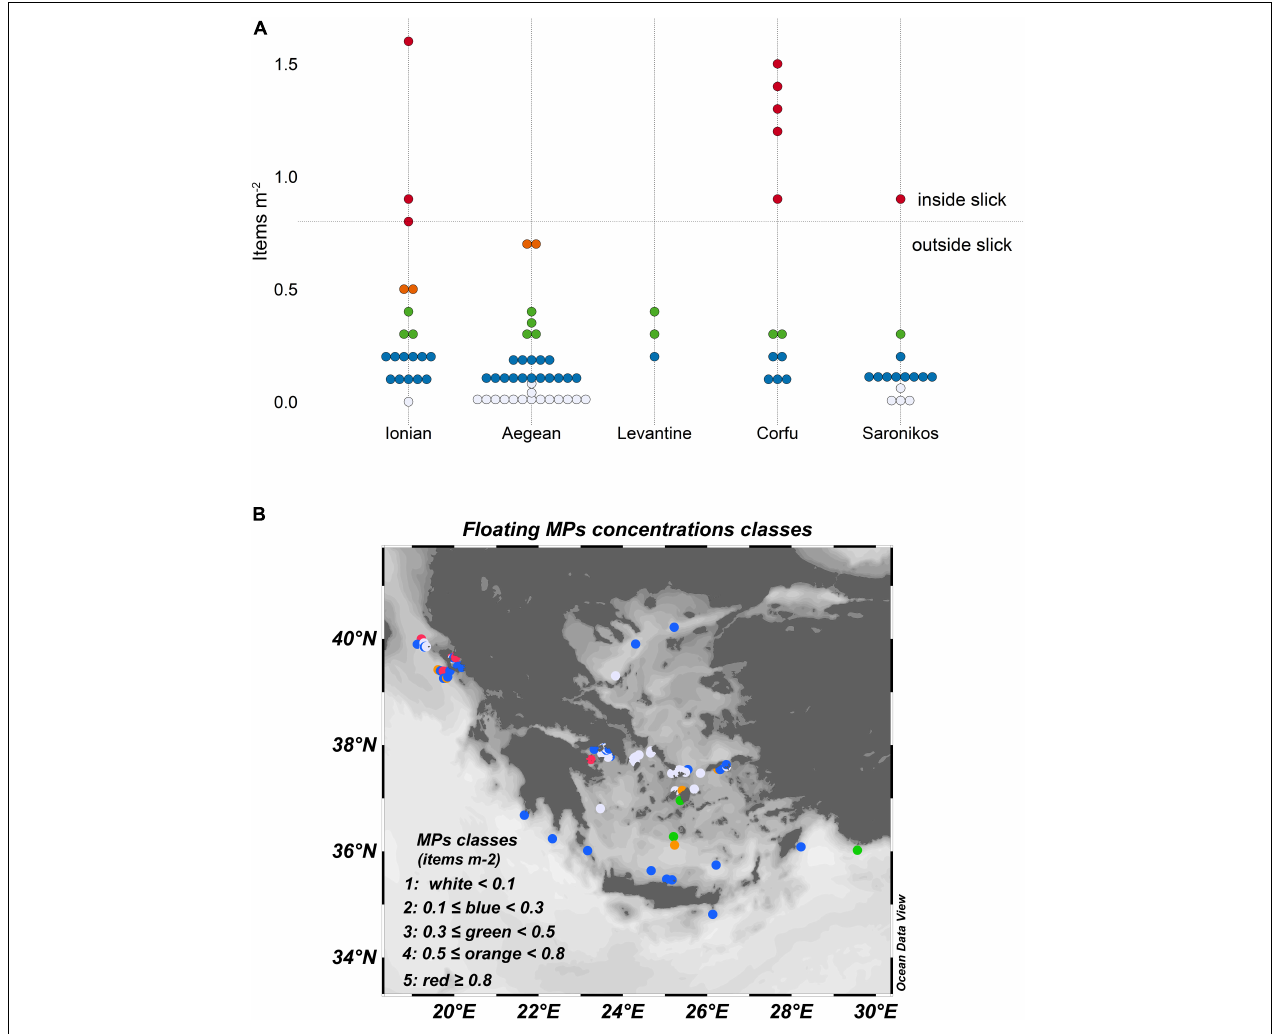
FIGURE 2 | Dot-plot diagram of microplastics (MPs) concentrations (items m -2 ) in the five sampled areas. Concentrations of samples collected inside and outside the slicks are separated by the horizontal line at 0.8 items m -2 (A) . Map showing floating MPs concentration classes for all sampling positions (B) . Colors in figures correspond to 5 MPs concentration classes (items m -2 ) as follows: 1: white < 0.1; 2: 0.1 ≤ blue < 0.3; 3: 0.3 ≤ green < 0.5; 4: 0.5 ≤ orange < 0.8; and 5: red ≥ 0.8 items m -2